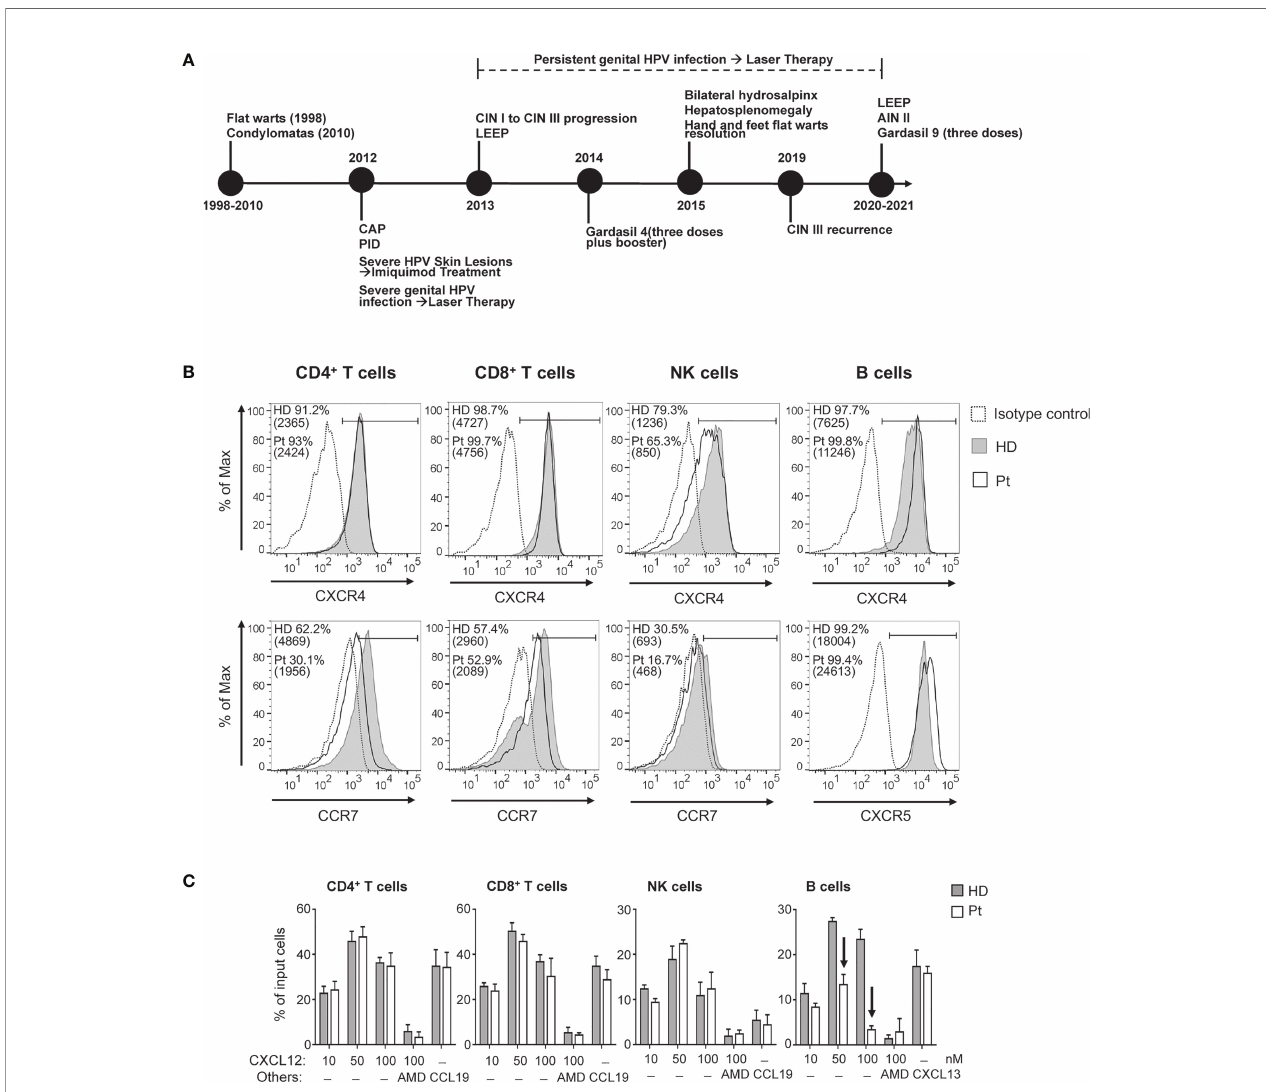
FIGURE 1 | (A) Clinical history of the patient (CAP, community acquired pneumonia; PID, pelvic in fl ammatory disease; CIN, cervical intraepithelial neoplasia; AIN, anal intraepithelial neoplasia; LEEP, loop electrosurgical excision procedure). Chemokine receptor expression and chemotactic response of blood lymphocyte subsets. (B) Cell surface expression of CXCR4, CCR7 and CXCR5 was analyzed in CD4 + T, CD8 + T, NK, and B cells upon immunolabeling of peripheral blood cells from the patient (Pt; open histograms) and age-matched HD ( fi lled gray histograms). The control IgG signal (dashed lines) is also shown. Values corresponding to percentage of positive cells as well as MFI (in brackets) are reported. (C) The chemotactic response of blood lymphocyte subsets was analyzed using whole blood samples from HD and Pt; results are expressed as percentage of input cells responding to the indicated concentrations of CXCL12, to 100 nM CCL19, or 300 nM CXCL13. AMD: AMD3100. Arrows indicate chemotactic responses notably reduced in Pt as compared with